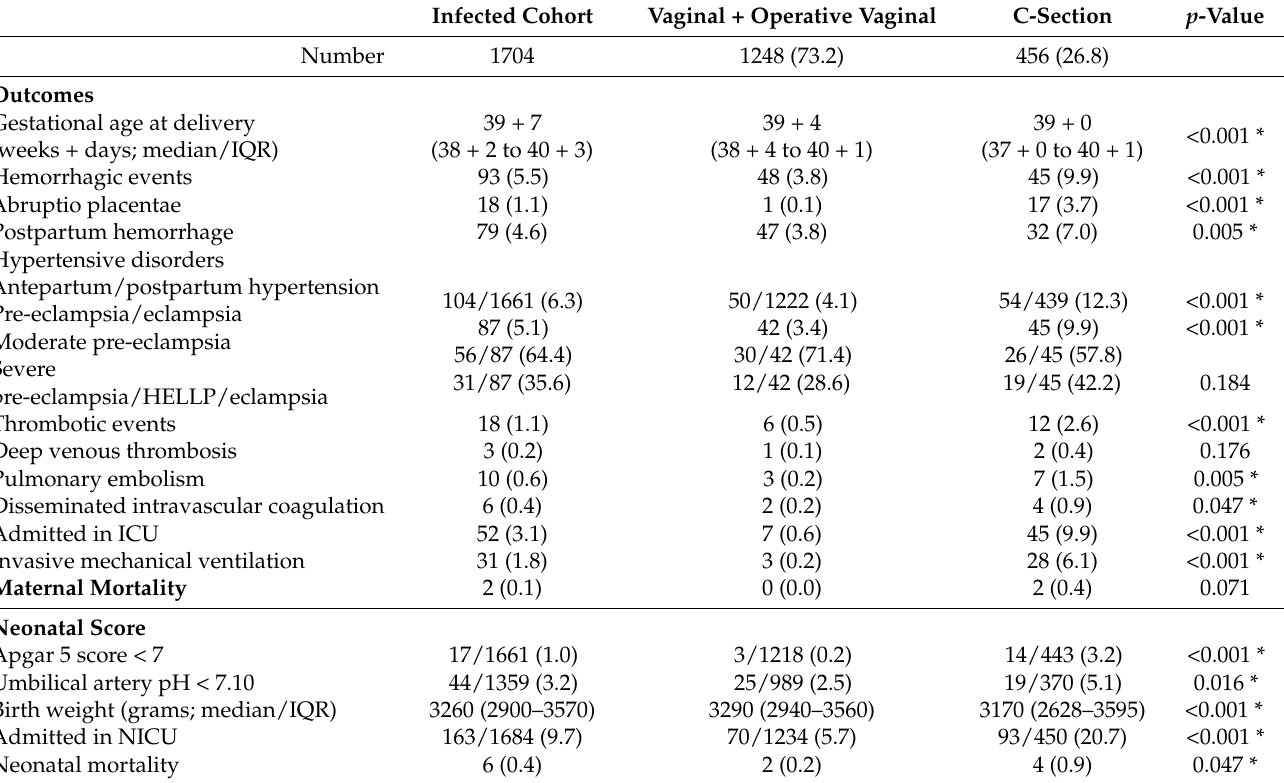
Table 2. Maternal and neonatal outcomes of the study participants (n =